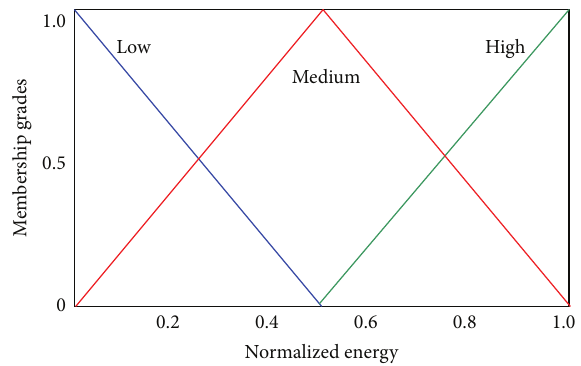
Figure 2: Membership function plots for fuzzy sets corresponding to low , medium , and high normalized energy ( 𝜉 norm